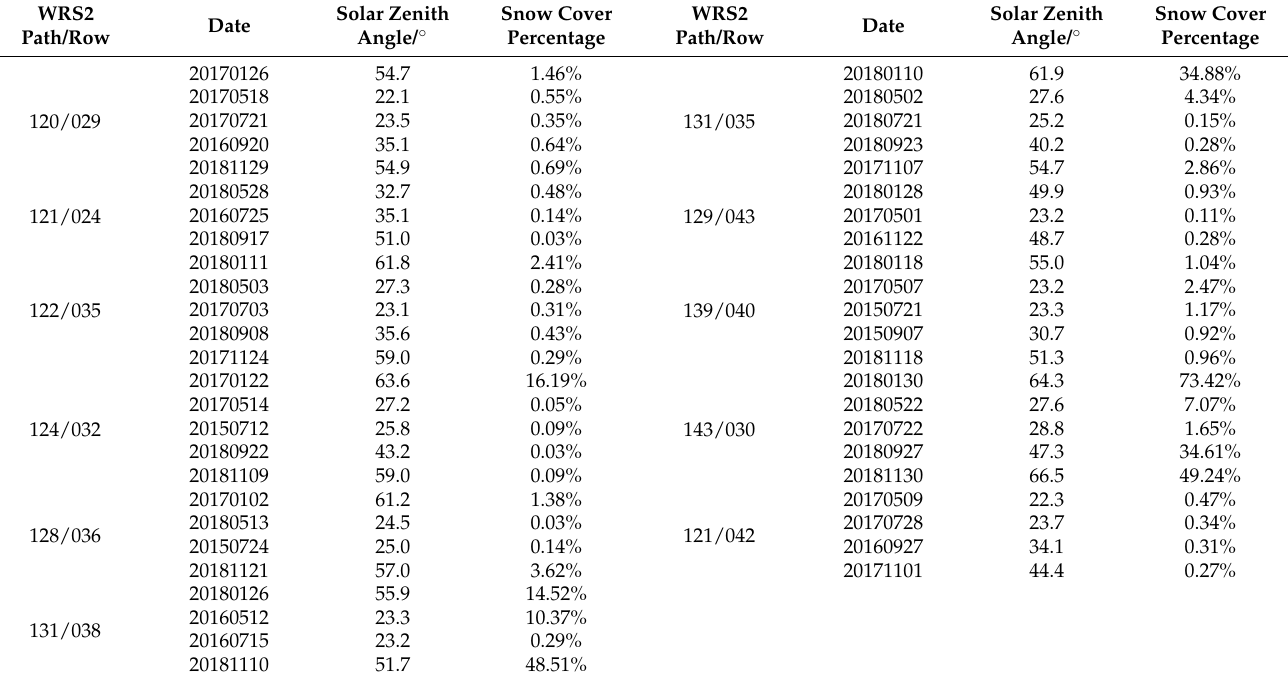
Table 3. Data acquisition and snow-cover information of Landsat 8 surface reflectance products included for topographic correction evaluation. WRS2